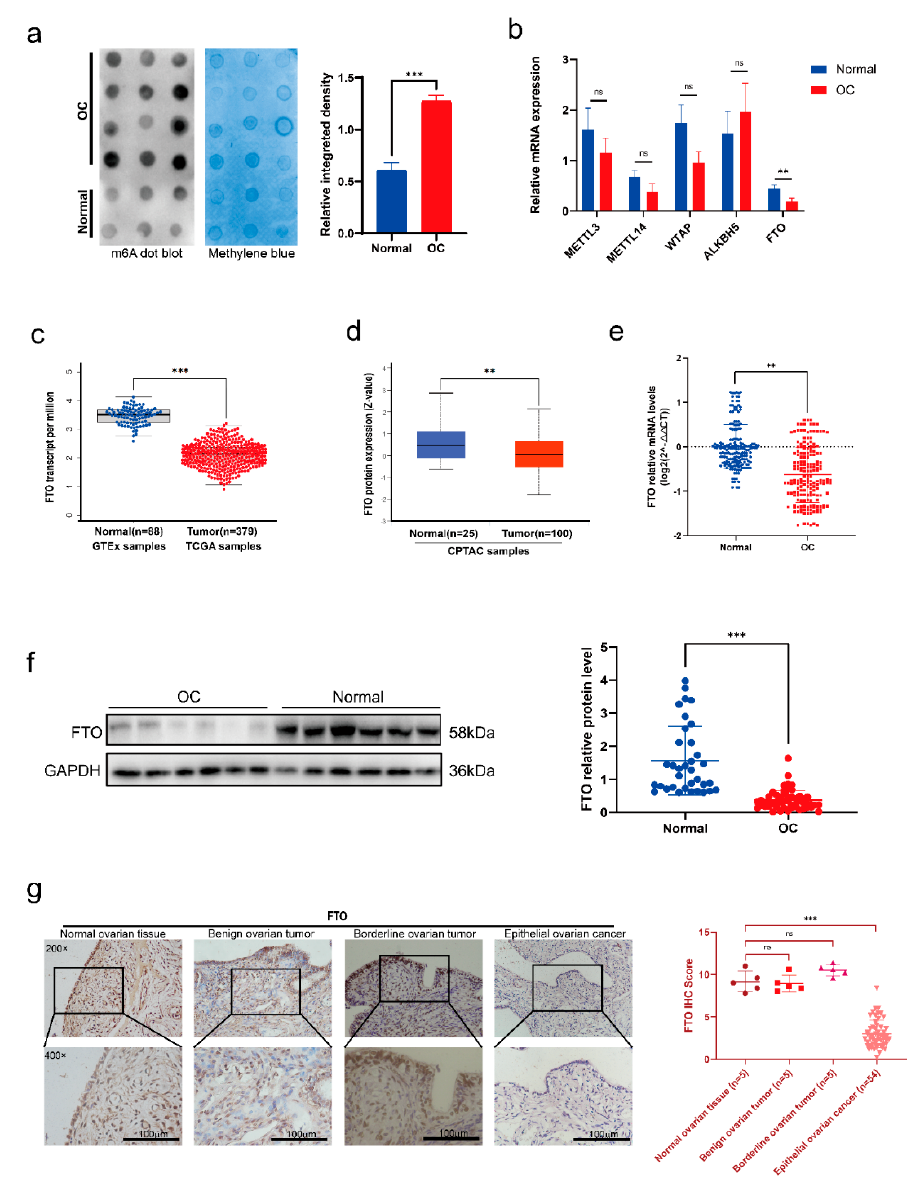
Figure 1. Lower expression of FTO in EOCs compared with normal ovarian tissues. ( a ) m6A levels of EOC and normal ovarian tissues by m6A dot blot. ( b ) Expression levels of the key enzymes of m6A in EOC and normal ovarian tissues by RT − qPCR. ( c ) The abundance of FTO transcripts from the TCGA database and the GTEX database. ( d ) Analysis of FTO protein level in the CPTAC database. ( e ) The mRNA level of FTO in 60 paired EOC and normal ovarian tissues detected by RT − qPCR. ( f ) FTO protein expression in 53 EOC and 35 normal ovarian tissues detected by Western blot. ( g ) FTO expression in normal ovarian tissues, benign, borderline epithelial tumours, and EOC detected by IHC assay. Scale bar, 100 µ m. Data are presented as mean ± SD. ns, not significant; ** p < 0.01; *** p < 0.001. The uncropped blots are shown in Supplementary Materials File